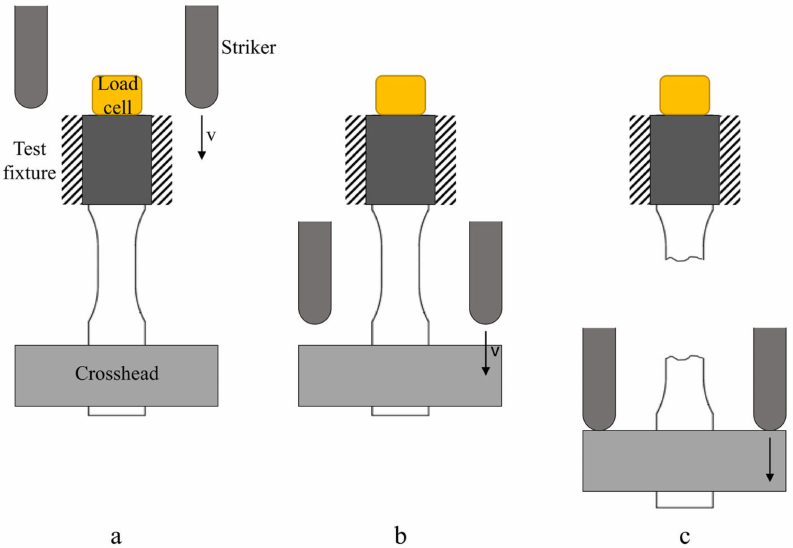
Figure 3. Schematic representation tensile impact test (A Method): ( a ) initial set up, ( b ) striker displacement and ( c ) break of the